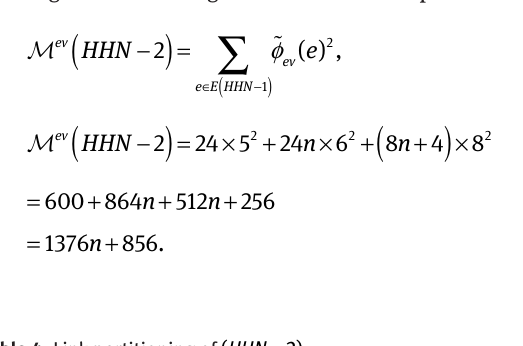
Table 4: Link partitioning of (